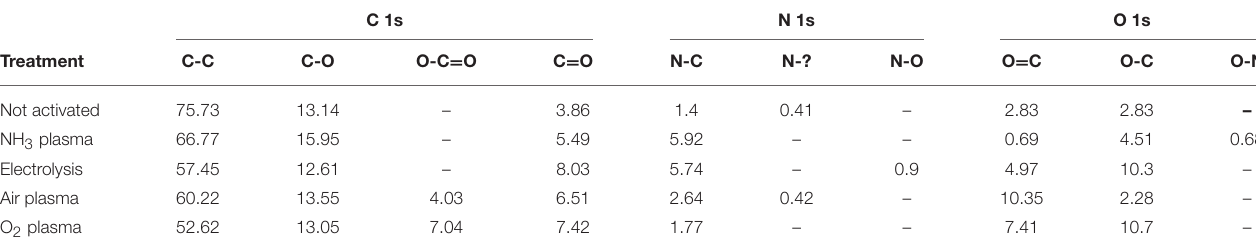
TABLE 5 | High-resolution XPS spectra analysis of surface activated HTS40 fibers.